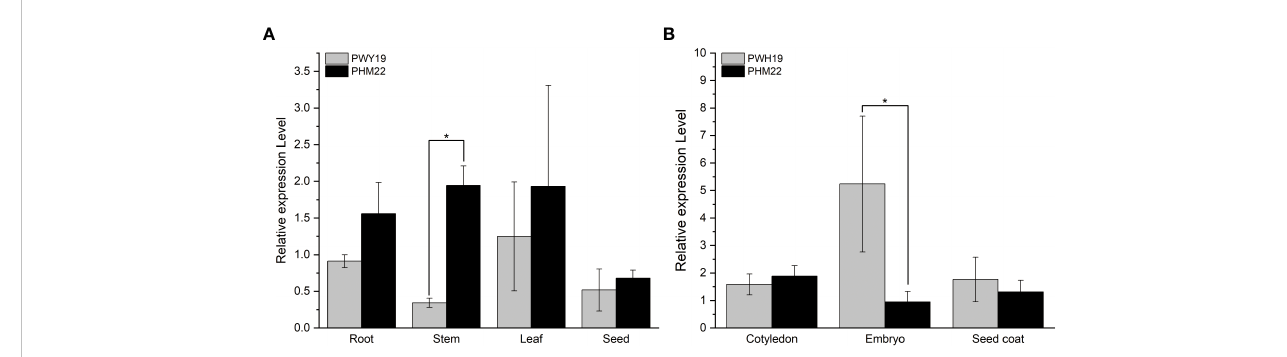
FIGURE 7 Relative expression levels of PsXI in PWY19 and PHM22. (A) Expression levels of PsXI in different tissues. (B) Expression levels of PsXI in cotyledon, embryo, and seed coat of seeds at 20 days after fl owering. Three biological replicates were used to produce average expression levels. The asterisks (*) represent signi fi cant differences ( P < 0.05) as determined by Student ’ s t-test.